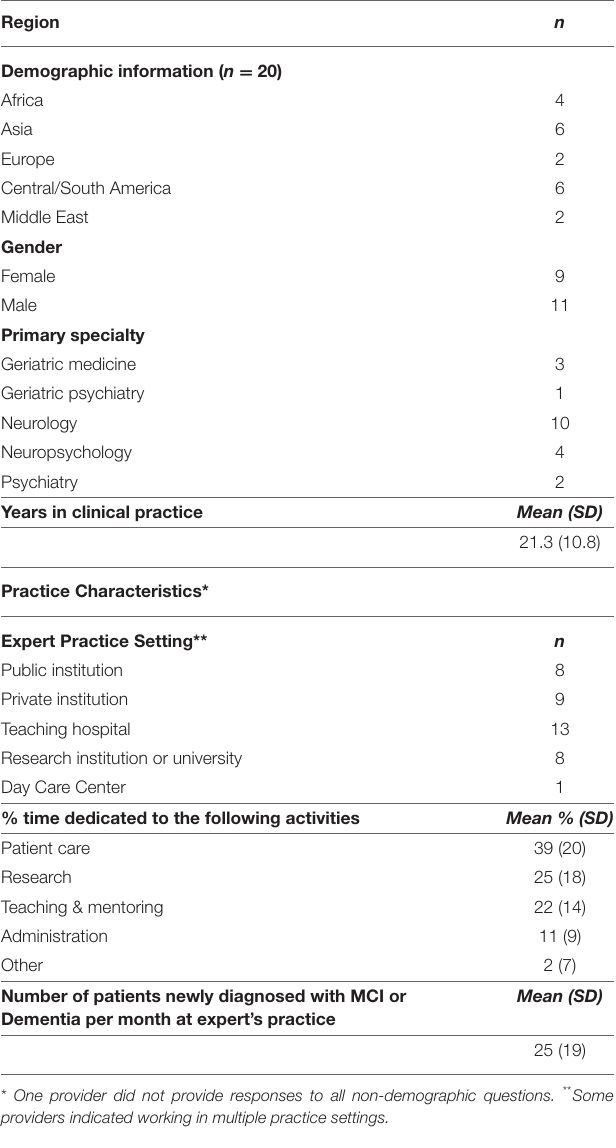
TABLE 2 | Participant demographics and practice